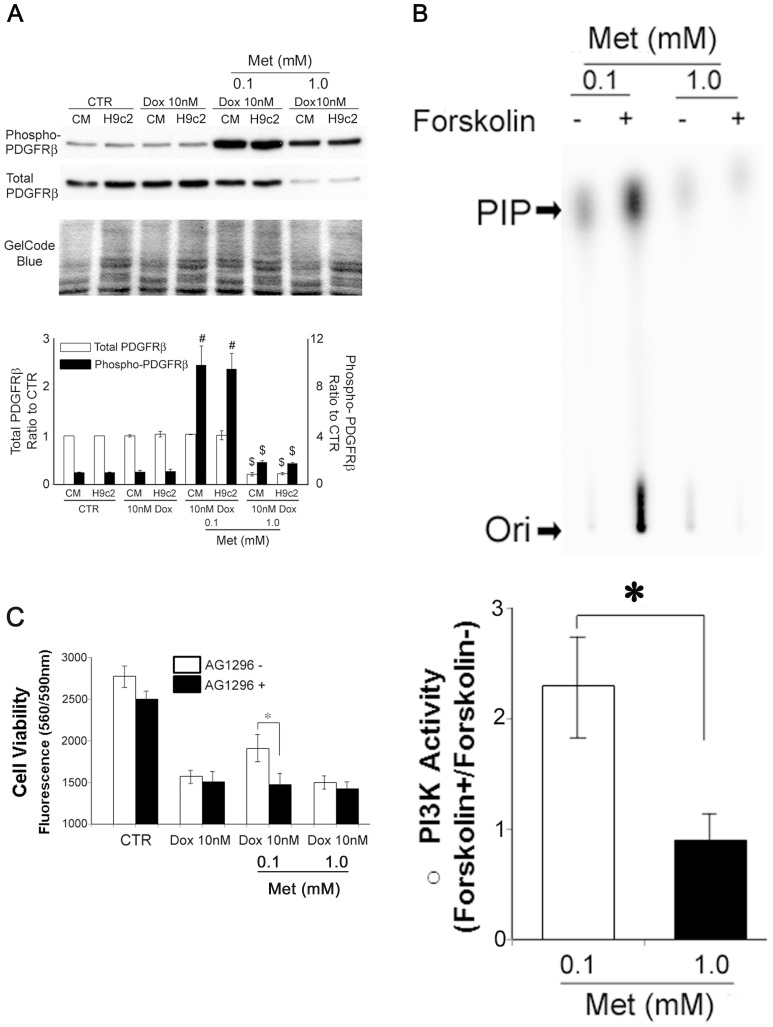
High dose Met abrogates the protective effects against Dox by suppressing the PDGFR expression.(A) Rat neonatal primary cardiomyocytes (CM) and H9c2 cardiomyoblasts were cultured with reduced FBS (1%) for 72 hours, with the indicated conditions. Cell lysates from the culture were subject to Western blotting using antibodies against phosphorylated or total platelet-derived growth factor receptor β-subunit (PDGFRβ). An image of the gel stained with GelCode Blue dye (Thermo) after transfer was shown as a loading monitor. The histograms show the densitometric scanning results. (B) Quiescent H9c2 cells were incubated with 0.1 or 1.0 mM metformin (Met) for 5 minutes with or without forskolin (1 µM). After the treatment, PI3K activities were determined as described in Materials and Methods. The histograms show the densitmetric scanning results. PIP, phosphoinositide 3-phosphate. Ori, origin of migration in thin-layer chromatography. (C) H9c2 cells were cultured for 72 hours with reduced FBS (1%), under the indicated conditions with or without AG1296 (10 µM). The cell viabilities were evaluated as described. * p<0.05, # p<0.05 vs CTR, $ p<0.05 vs Dox 10 nM + Met 0.1 mM. Values represent mean ± S.D. (n = 4) from quadruplicate samples for each treatment at varying treatment conditions.